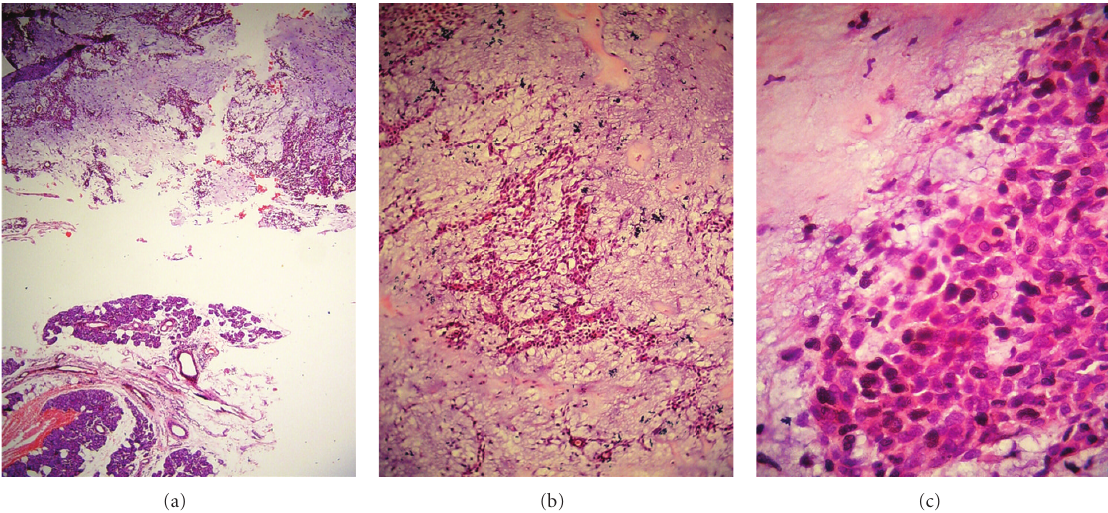
Figure 2: High power view of pleomorphic adenoma. The epithelial component is seen in the background of myxochondroid